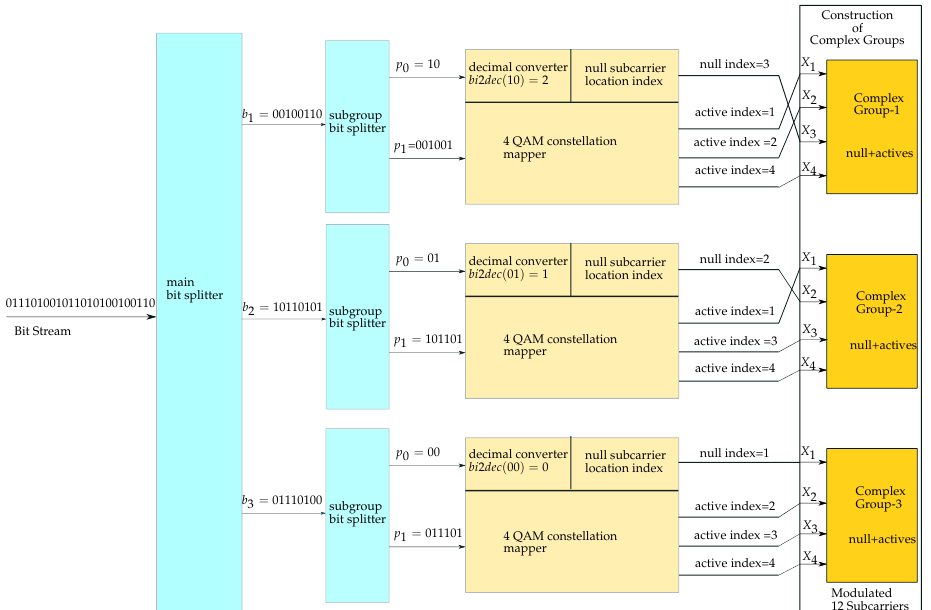
Figure 6. Example of the NSC-OFDM-IM transmitter.